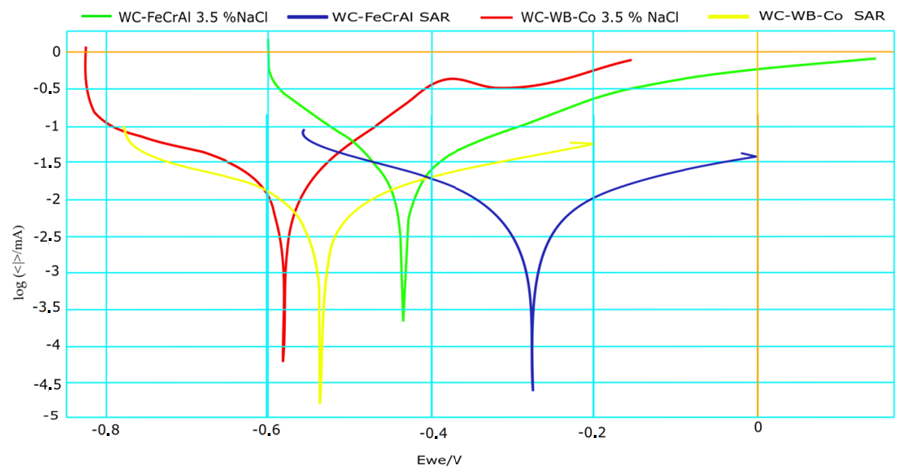
Figure 9. Potentiodynamic polarizing curves of exposed samples. Table 6. Values of corrosion potential, current density, and slopes of cathode and anode dependence. Testing solution